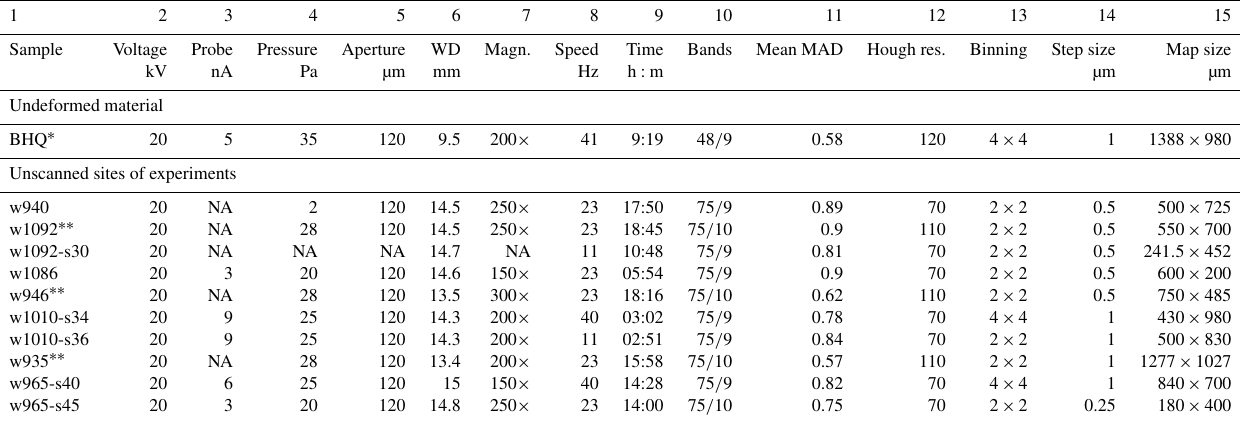
Table A1. EBSD data acquisition.